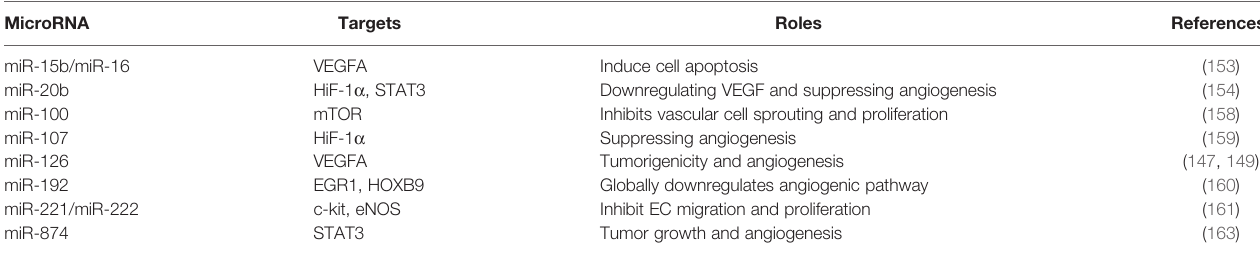
EGR1, early growth response protein 1; HOXB9, homeobox (HOX) B9; eNOS, endothelial nitric oxide